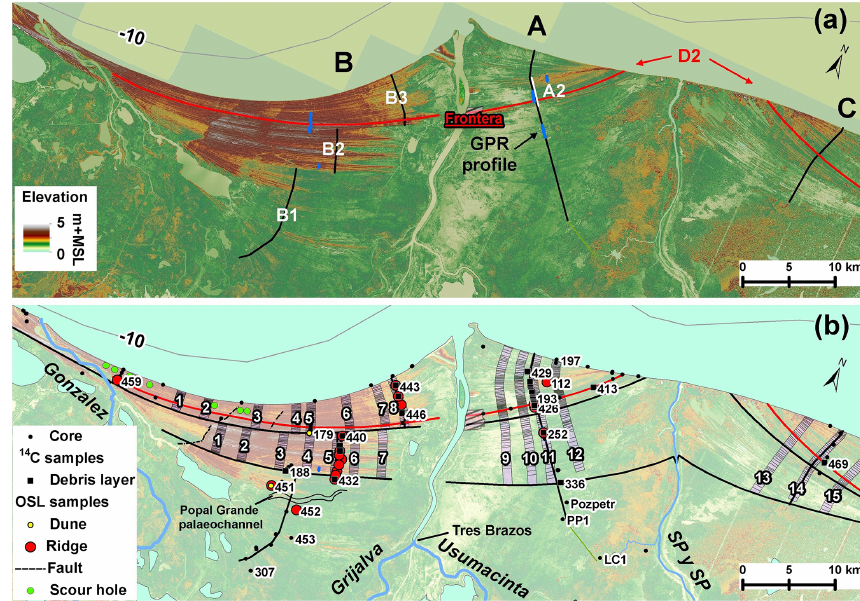
Figure 2. (a) Lidar-based DEM and location of studied transects with the GPR transects in blue. (b) Main beach-ridge formation phases and the locations of sediment cores (black) and samples collected for OSL and AMS 14 C dating. Numbers 1–15 denote the 15 cross-normal ribbon-shaped elevation transects, in the text referred to as B2-1, B2-2,